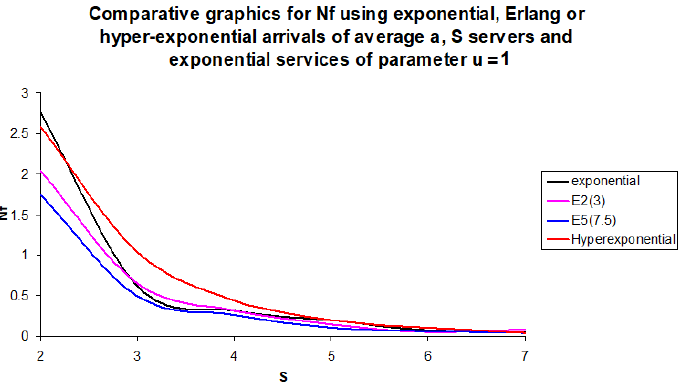
Figure 13. Comparative graphics for N f.